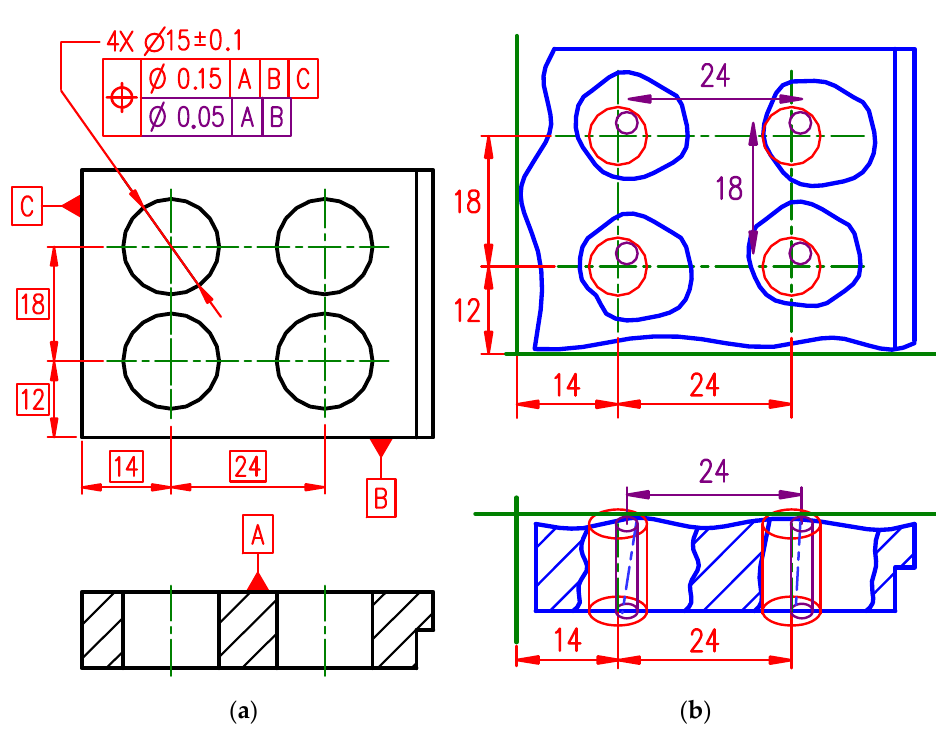
Figure 15. ( a ) Position tolerance T = 0.15 mm locates the pattern with respect to datum system A|B|C, position tolerance T = 0.05 mm refines mutual location between holes and limits rotation of the pattern with respect to the datum system A|B (ASME Y14.5); ( b ) tolerance zones—meaning of two level specification.